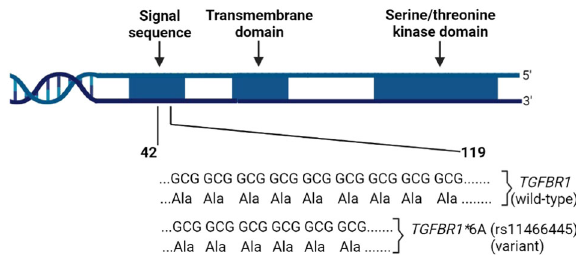
Fig. 1 TGFBR1 and TGFBR1* 6A gene and protein sequences. Sequence analyses reveal nine (9) GCG/alanine repeats within nucleotides 42 – 119 of the TGFBR1 signal sequence. TGFBR1* 6A variant has six (6) GCG/alanine repeats in its signal